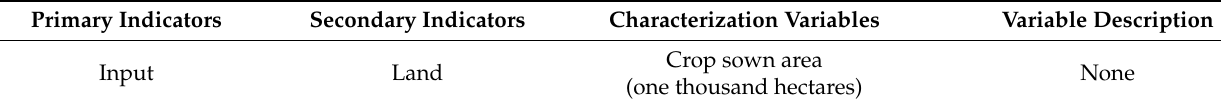
Table 1. Description of the input-output